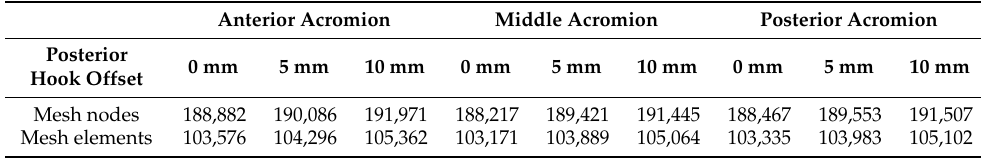
Table 2. The number of elements and nodes in each group after mesh.